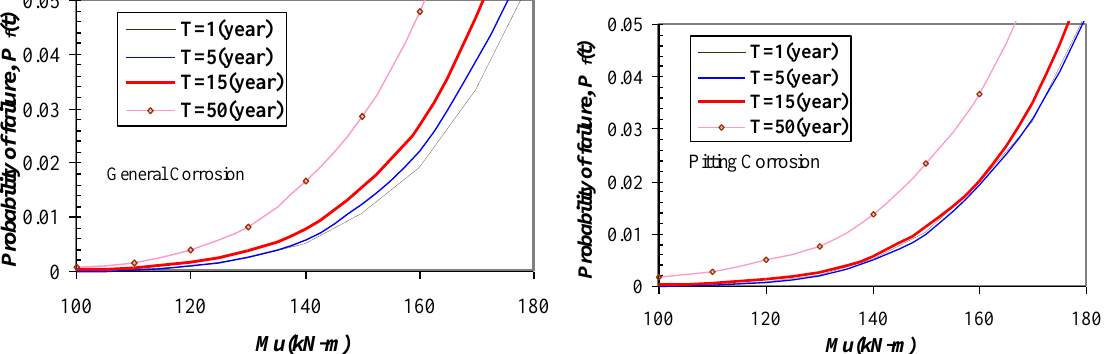
Fig. 4. Compression of failure probability to external moment for initial time since